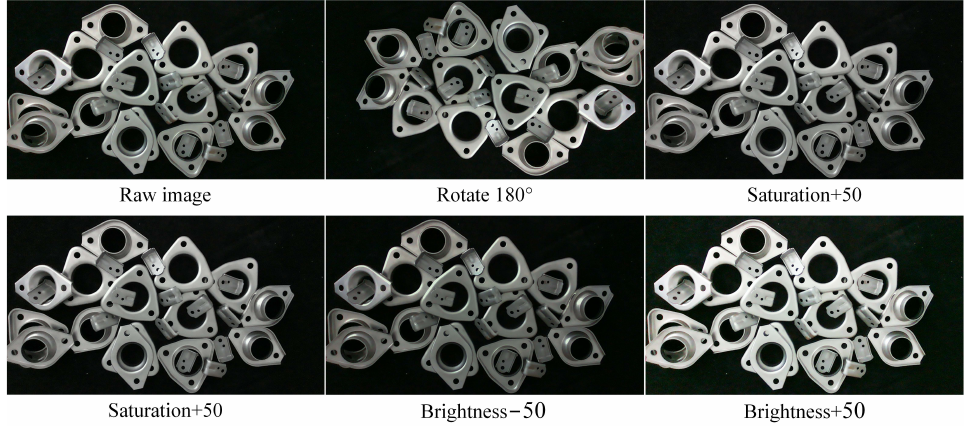
Figure 8. The details of hardware included in the dataset.